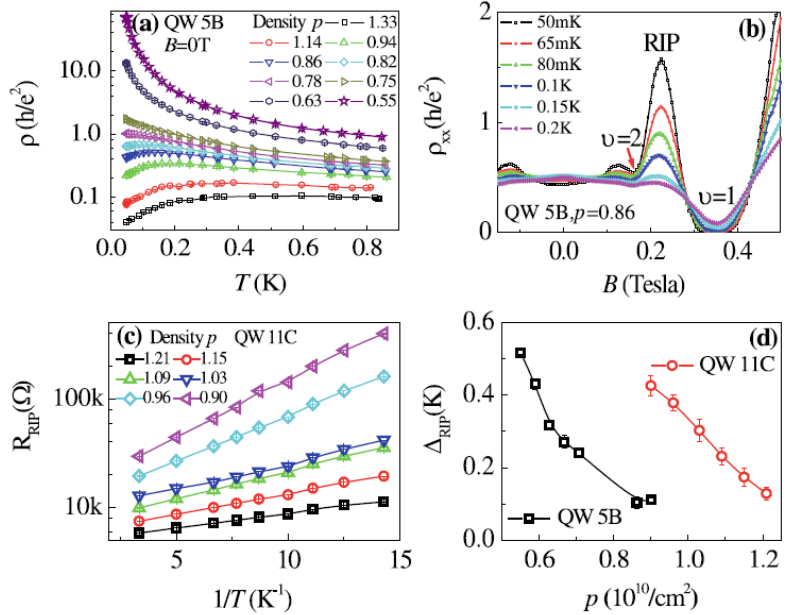
Figure 3. ( a ) 2D MIT at a zero magnetic field in a dilute 2D hole system in a 10 nm wide GaAs quantum well, p c ∼ 0.8 × 10 10 /cm 2 . ( b ) ρ xx ( B ) with p = 0.86 × 10 10 /cm 2 . ( c ) Arrhenius plot of the RIP peak resistance at various hole densities. ( d ) The fitted thermal activation gap. Figure from Reference [10].